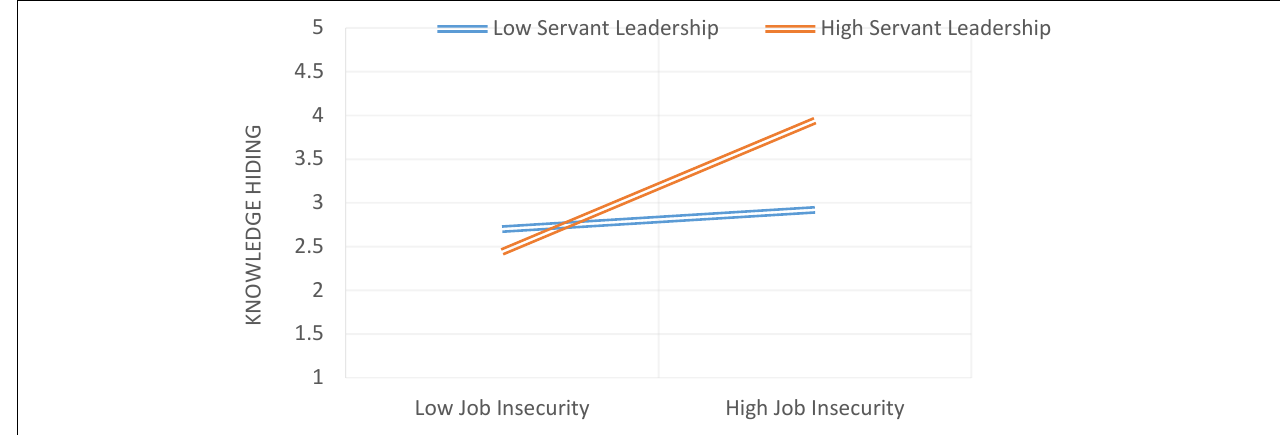
FIGURE 3 | The moderating role of servant leadership between job insecurity and knowledge hiding. TABLE 7 | Moderation analysis.